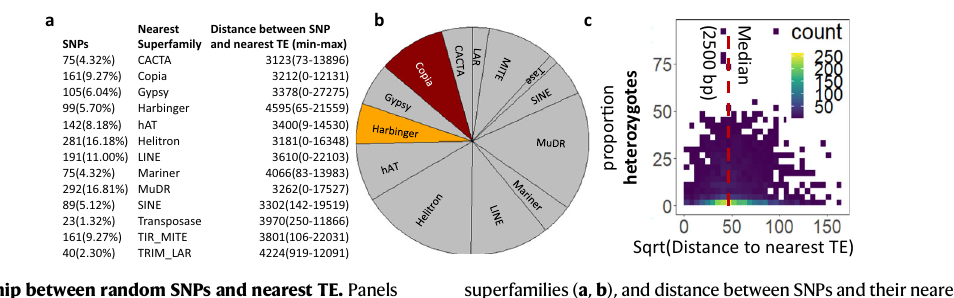
superfamilies( a , b ),anddistancebetweenSNPsandtheirnearestTE( c ).Panelsare based on 1734 independent SNPs. Source Data are provided as a Source Data fi le.